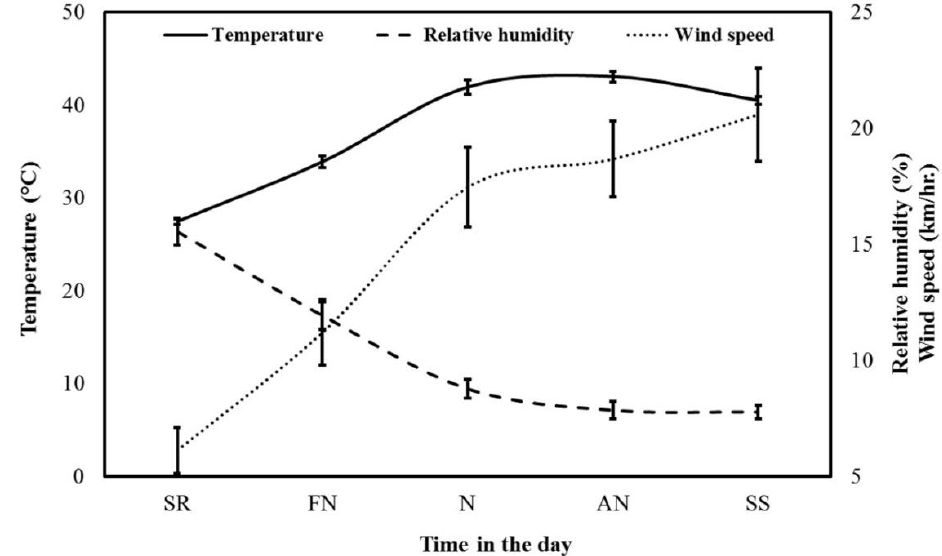
Figure 1. Hourly average values of weather factors during times in the day during the Acacia gerrardii flow (May-August) in Central Arabia for the 2017 and 2018 seasons (SR: sunrise; FN: forenoon; N: noon; AN: afternoon; SS: sunset).